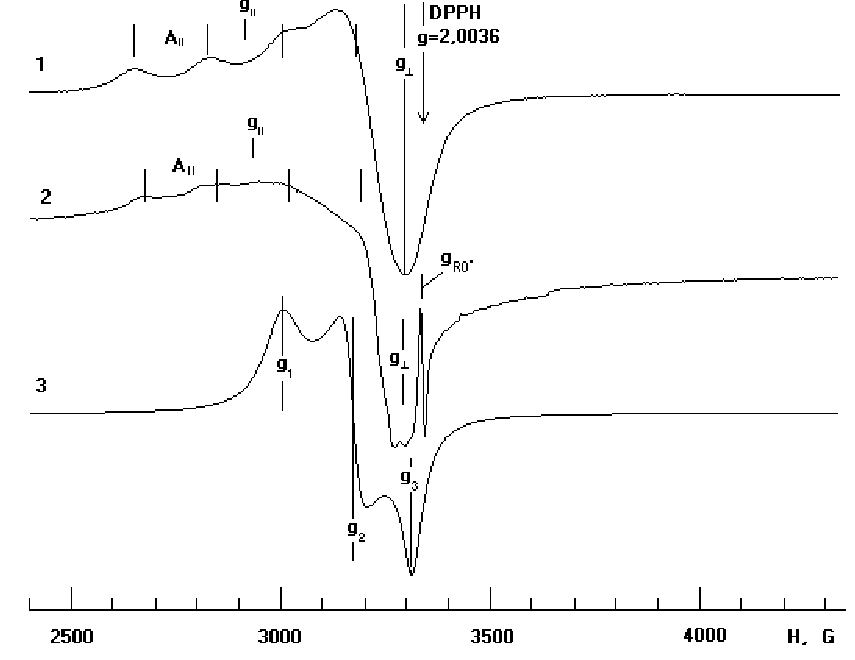
Fig. 1 ESR spectra of polycrystalline Cu(L I ) 2 (1), Cu(L II ) 2 (2) and Cu(L IV ) 2 (3) at 77